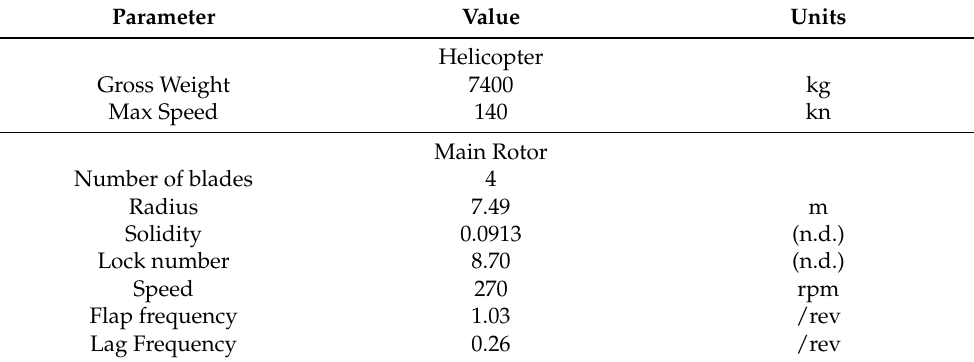
Table 1. AS-330 PUMA general characteristics [25]. Parameter Value Units Helicopter Gross